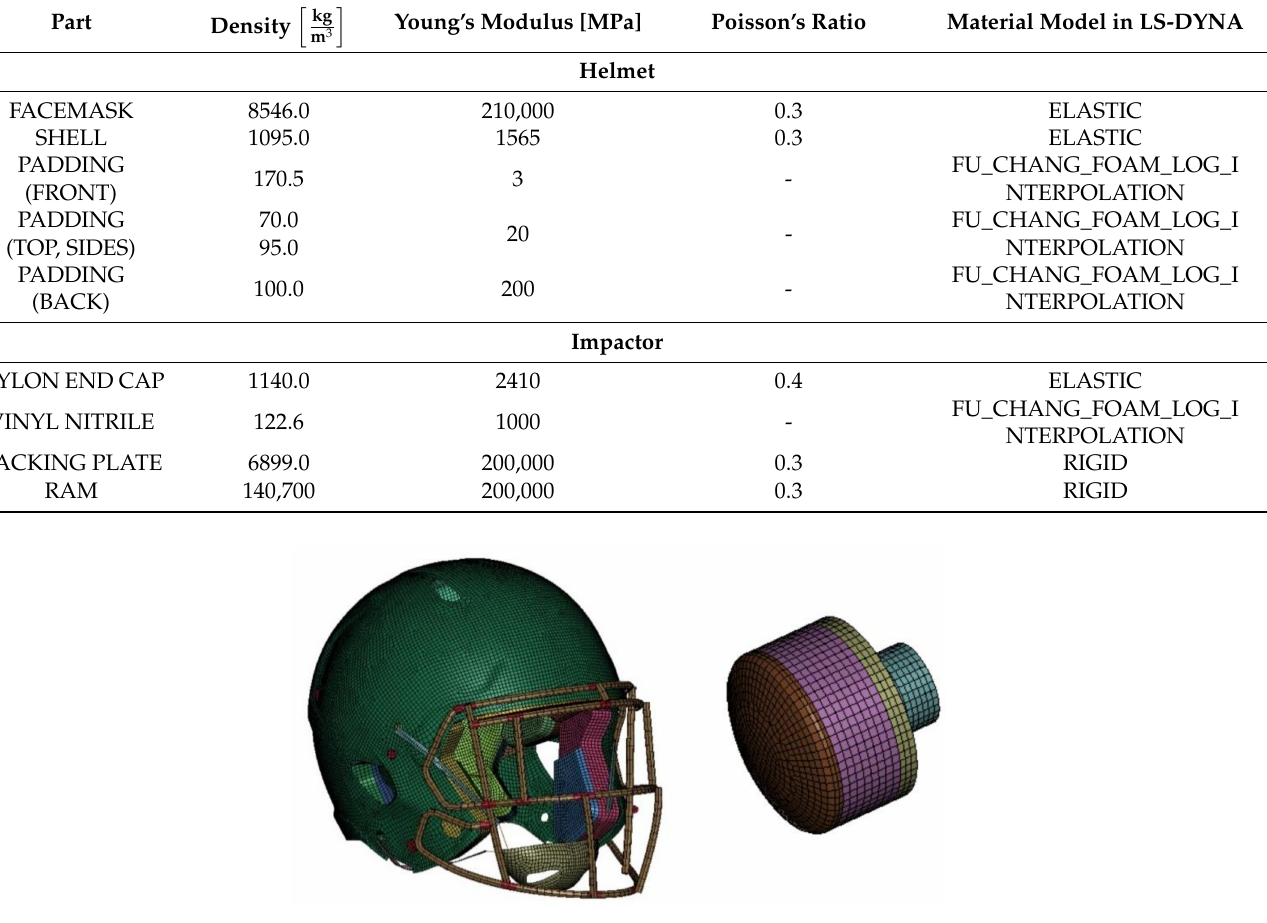
search, LLC (Biocore) [43,64]. The impactor model is composed of five different parts, and its overall mass is 15.4 kg